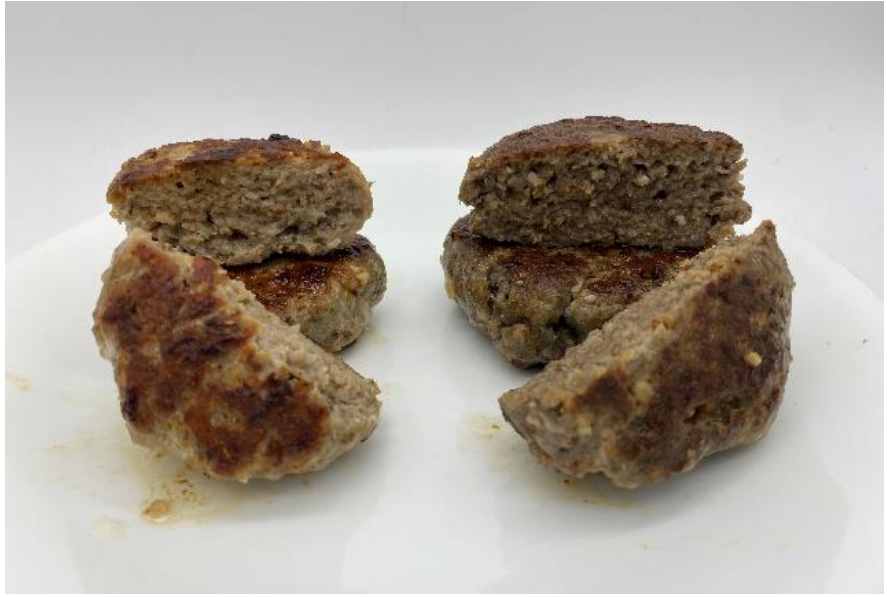
Figure 1. Control ( left ) and CP ( right ) sausage patties. Table 4. Proximate composition of the raw sausage (on a dry basis), color, pH, cooking yield, and textural properties of both sausages developed. The means with 95% confidence intervals are shown. All percentages were rounded to the nearest hundredth place. Parameters that were denoted were found to be significantly different ( p < 0.05). Product Type